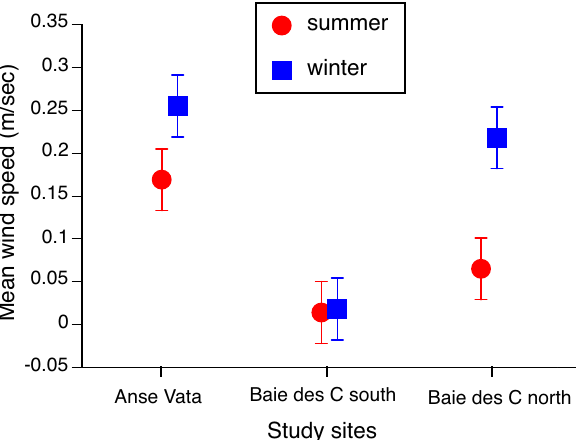
Figure 2. Mean wind speeds at the three study sites in summer and winter, based on orientation of the three sites with respect to prevailing wind directions combined with data on wind speeds and directions extracted from the Météo-France climate database for Noumea (http:// www. meteo. nc/ donne es- publi ques/ publi theque). Values were calculated separately for summer (October to April) and winter (May to September) 21 , based on mean monthly values. The graph shows mean values and associated standard errors.